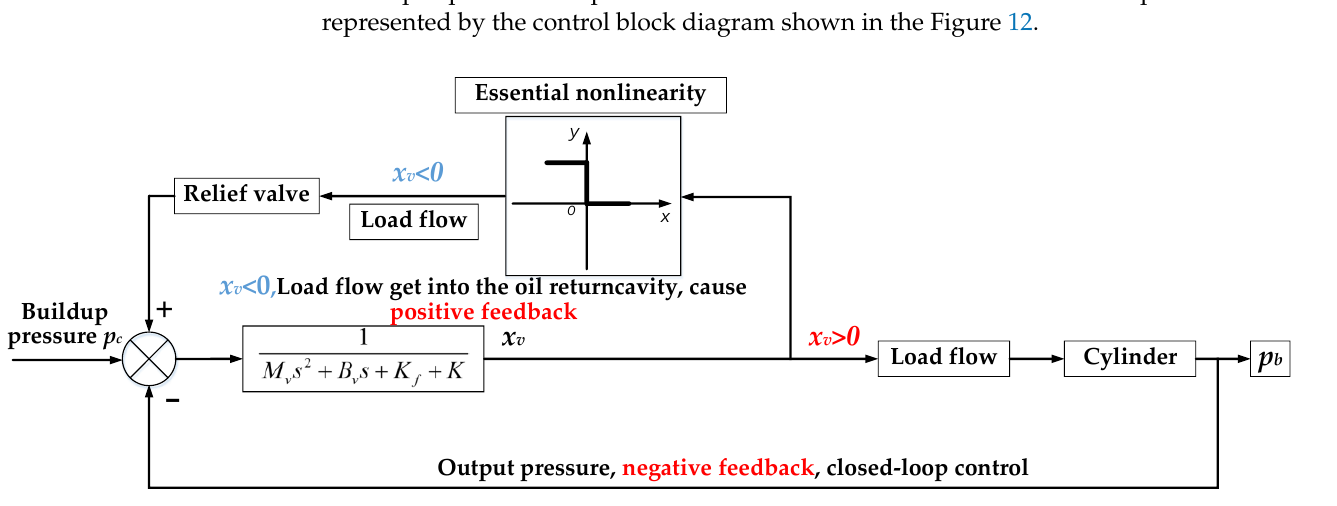
Figure 12. Pressure servo valve power stage feedback control block diagram.